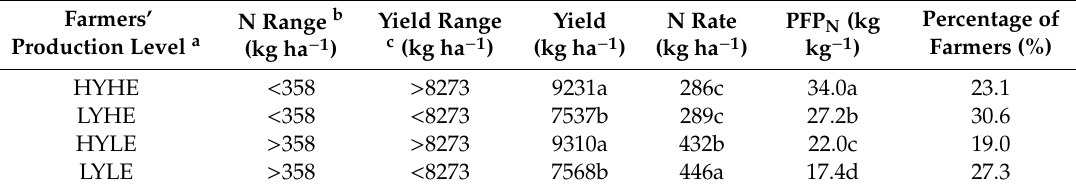
Table 1. Rice yield, N rate and partial factor productivity of applied N (PFP N ) of farmers grouped according to production level and nitrogen use e ffi